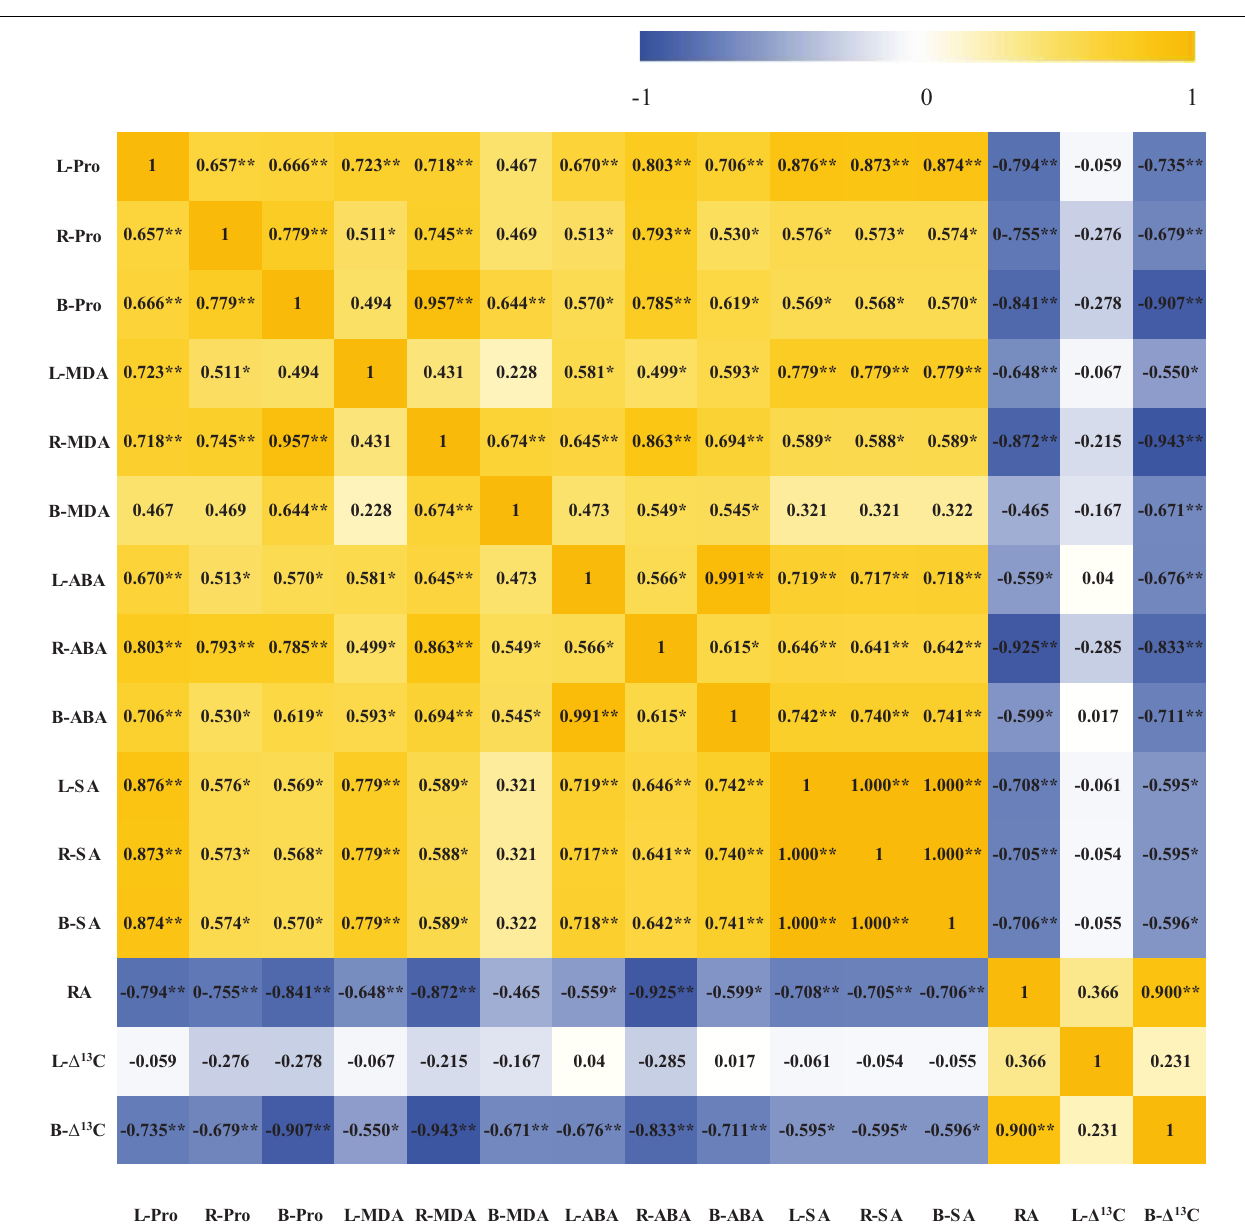
FIGURE 6 | Correlation analysis of various physiological indices. L-Pro, leaf proline; R-Pro, root proline; B-Pro, bract proline; L-MDA, leaf malondialdehyde; R-MDA, root malondialdehyde; B-MDA, bract malondialdehyde; L-ABA, leaf abscisic acid; R-ABA, root abscisic acid; B-ABA, bract abscisic acid; L-SA, leaf salicylic acid; R-SA, root salicylic acid; B-SA, bract salicylic acid; RA, root activity; L- (cid:49) 13 C, leaf (cid:49) 13 C; B- (cid:49) 13 C, bract (cid:49) 13 C; *represents a significant correlation at the P < 0.05 level and **represents a significant correlation at the P < 0.05 level.